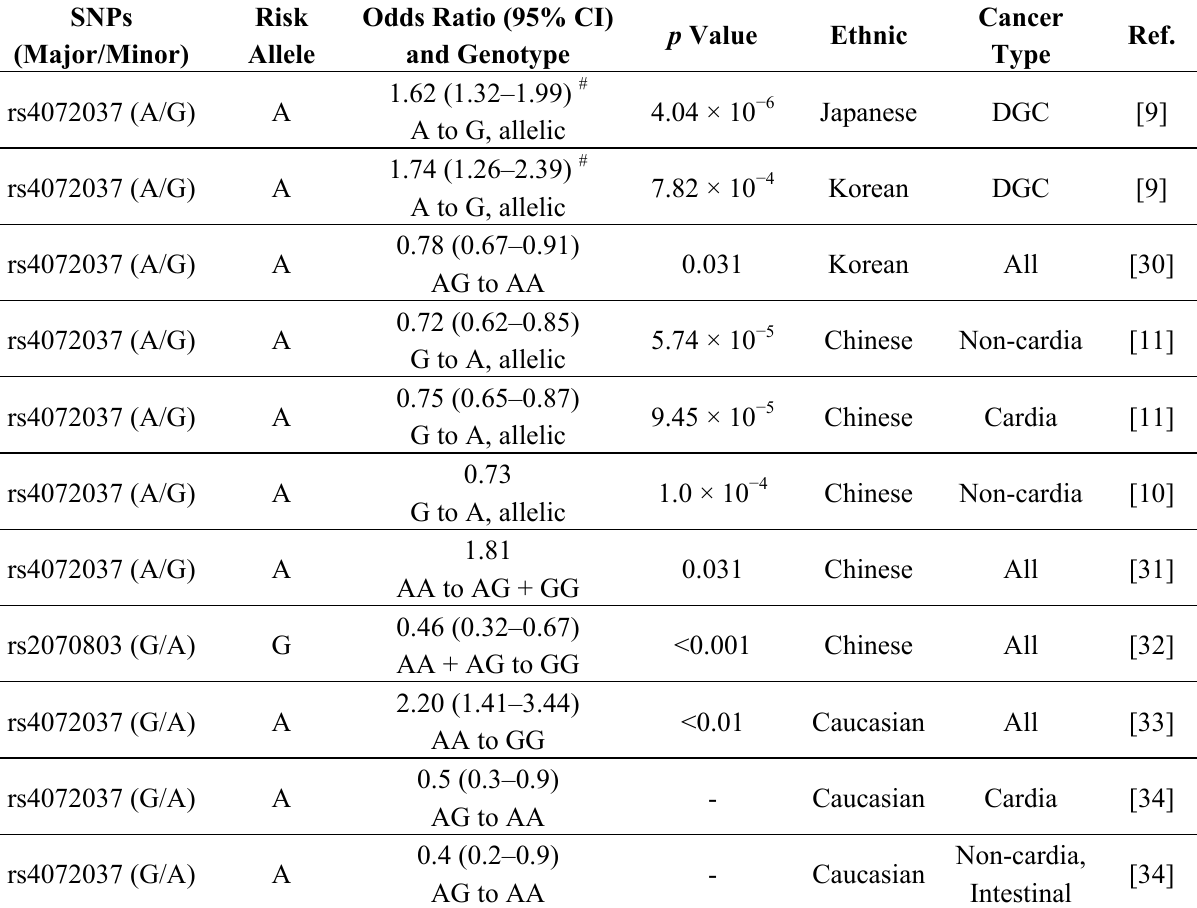
Table 1. Association between GC (gastric cancer) and MUC1 SNPs (single nucleotide polymorphisms). Ref. =